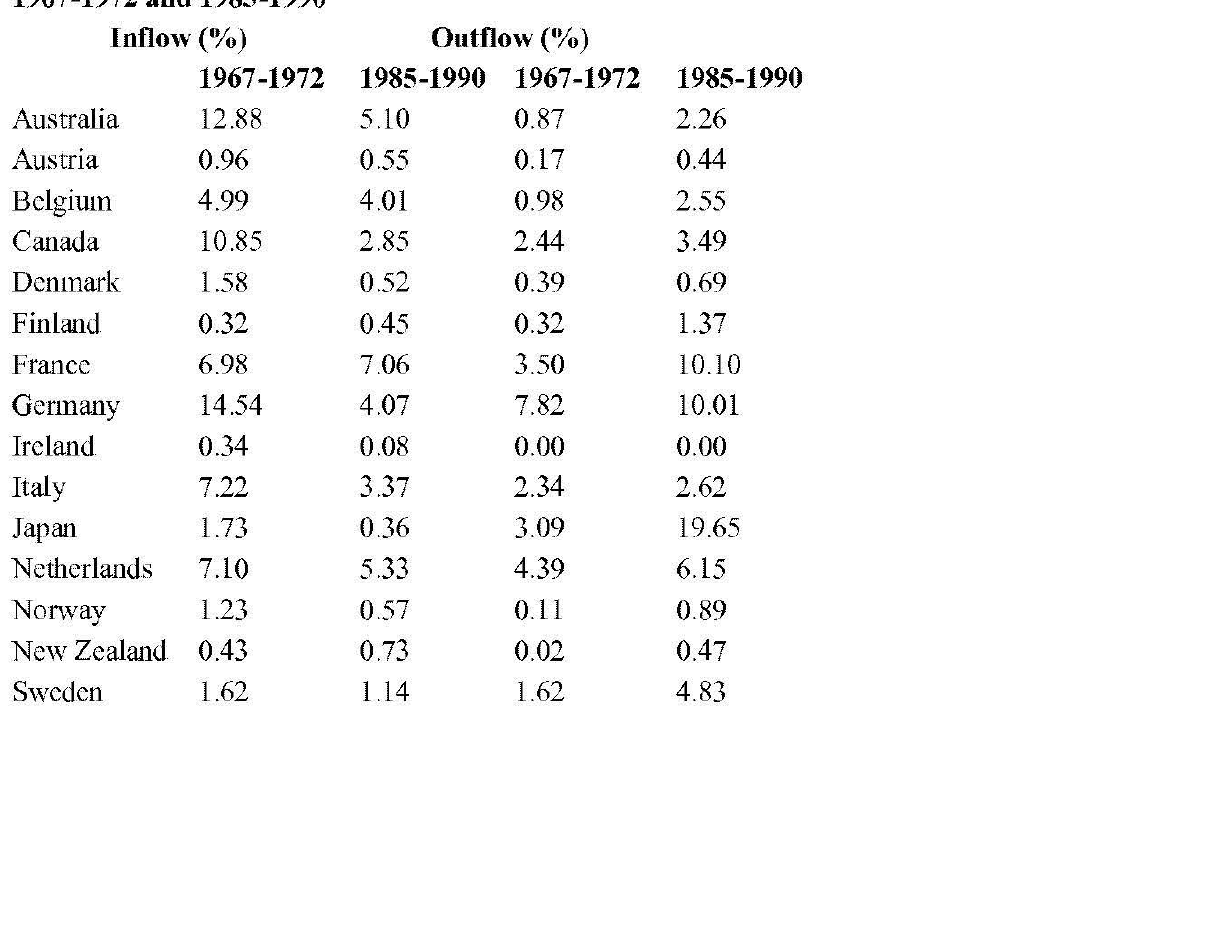
Table 2. Share of total inflow and outflow of direct investment in 17 OECD nations, 1967-1972 and